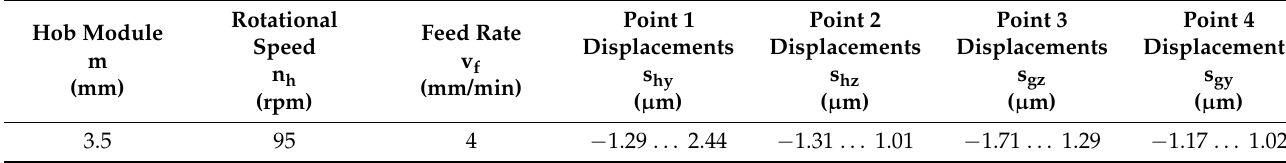
Table 2. Experimental results.